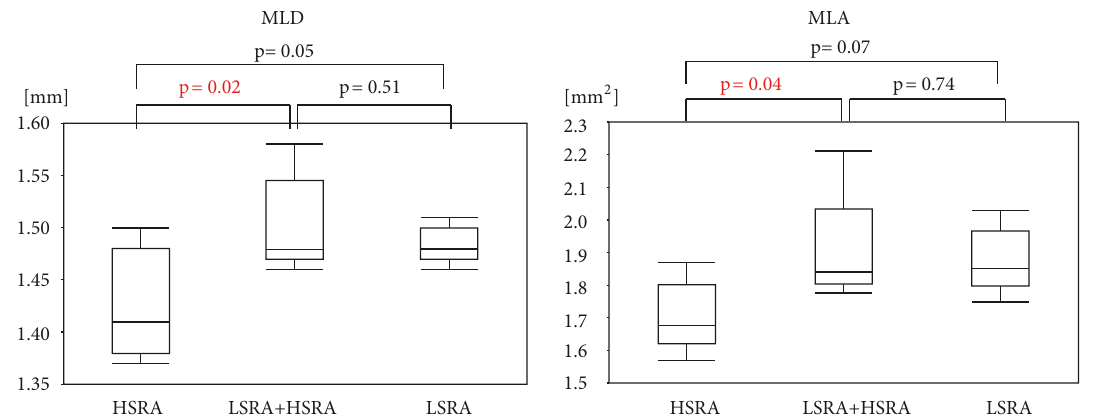
Figure 4: In-vitro Experiment (MLD and MLA after Ablation with 1.5 mm Rotablator Burr). Comparison of minimum lumen diameter (MLD) immediately after high-speed rotational atherectomy (HSRA), low-speed rotational atherectomy (LSRA) following HSRA.